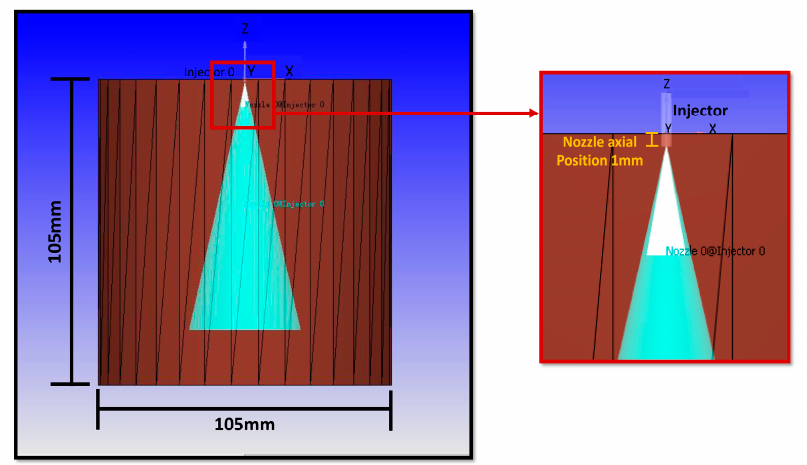
Figure 1. Model characteristics of cylinders.